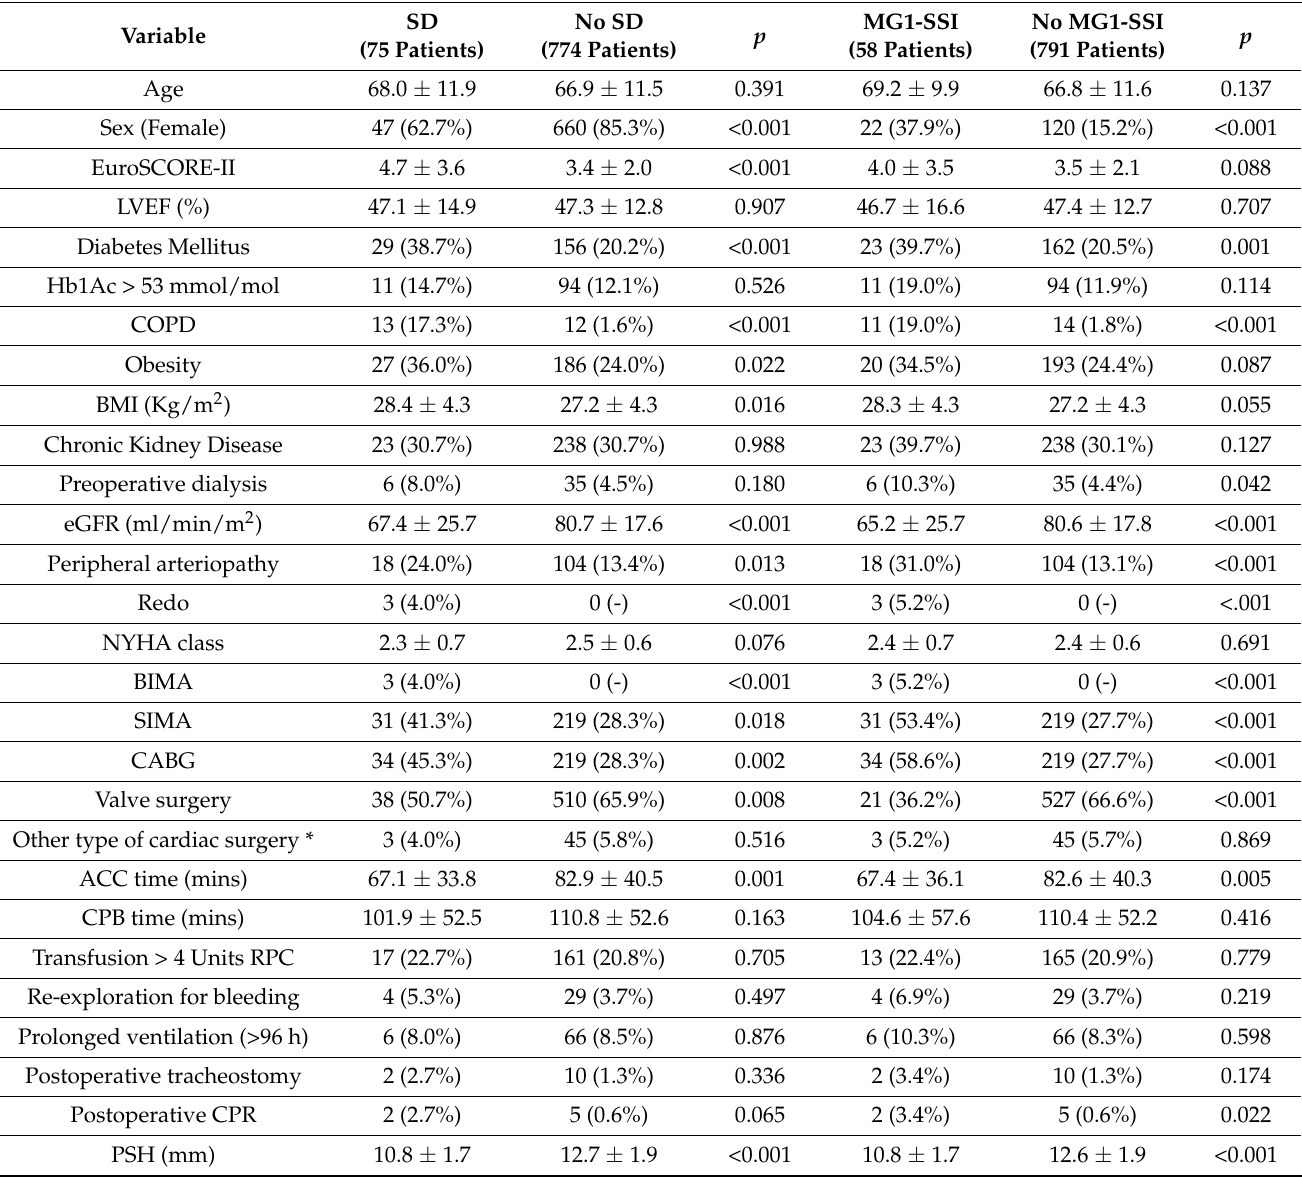
Table 3. Univariate analysis of clinical data and radiological measurements between patients developing SD and MG1-SSI or